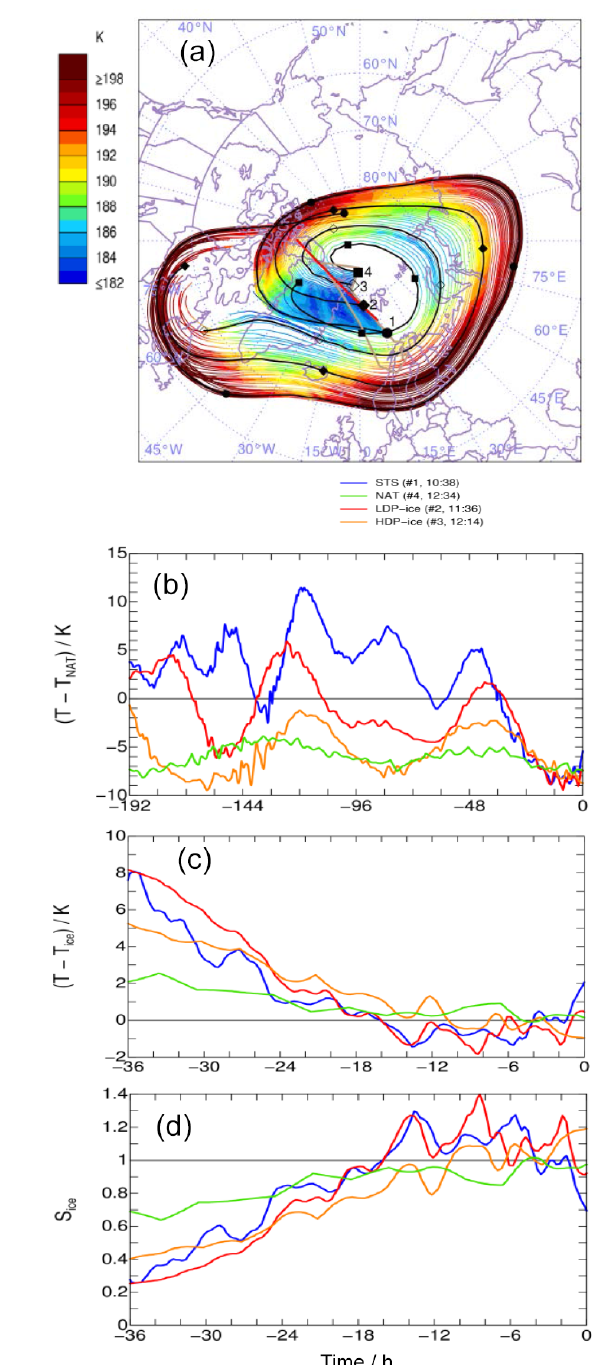
Figure 8. 8-day back-trajectories starting in the different PSC layers measured on 22 January 2016. (a) Temperatures (colour coded) of the back-trajectories derived from the IFS operational analysis (cycle 41r1) starting every 2min at 21.5 ◦ altitude in the PSC on 22 January 2016. Four back-trajectories starting in STS (1, circle), low-depol ice (2, LDP-ice, filled diamond), high-depol ice (3, HDP-ice, open diamond) and NAT Mix2 (4, square) are shown as black lines with small symbols marking every 48h. The HALO flight track is shown as brown line and the CALIPSO footprint as red line. The starting points of the four trajectories are also given in Figs. 4 and 5. The temperature evolution along the four trajectories (STS: blue, NAT: green, LDP-ice: red and HDP-ice: orange) is shown in panel (b) as temperature difference to T NAT for 8 days and (c) as the temperature difference to T ice for 36h prior to the observation. The ice saturation ratio S ice is given in panel (d) . T NAT is calculated from Hanson and Mauersberger (1988) for an altitude-dependent climatological HNO 3 profile; H 2 O, T ice and S ice are calculated from the meteorological data